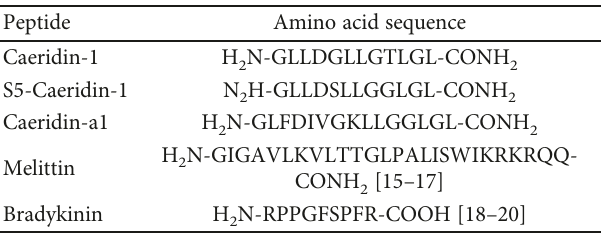
Table 5: The amino acid compositions of novel Caeridins, positive peptide melittin, and negative peptide